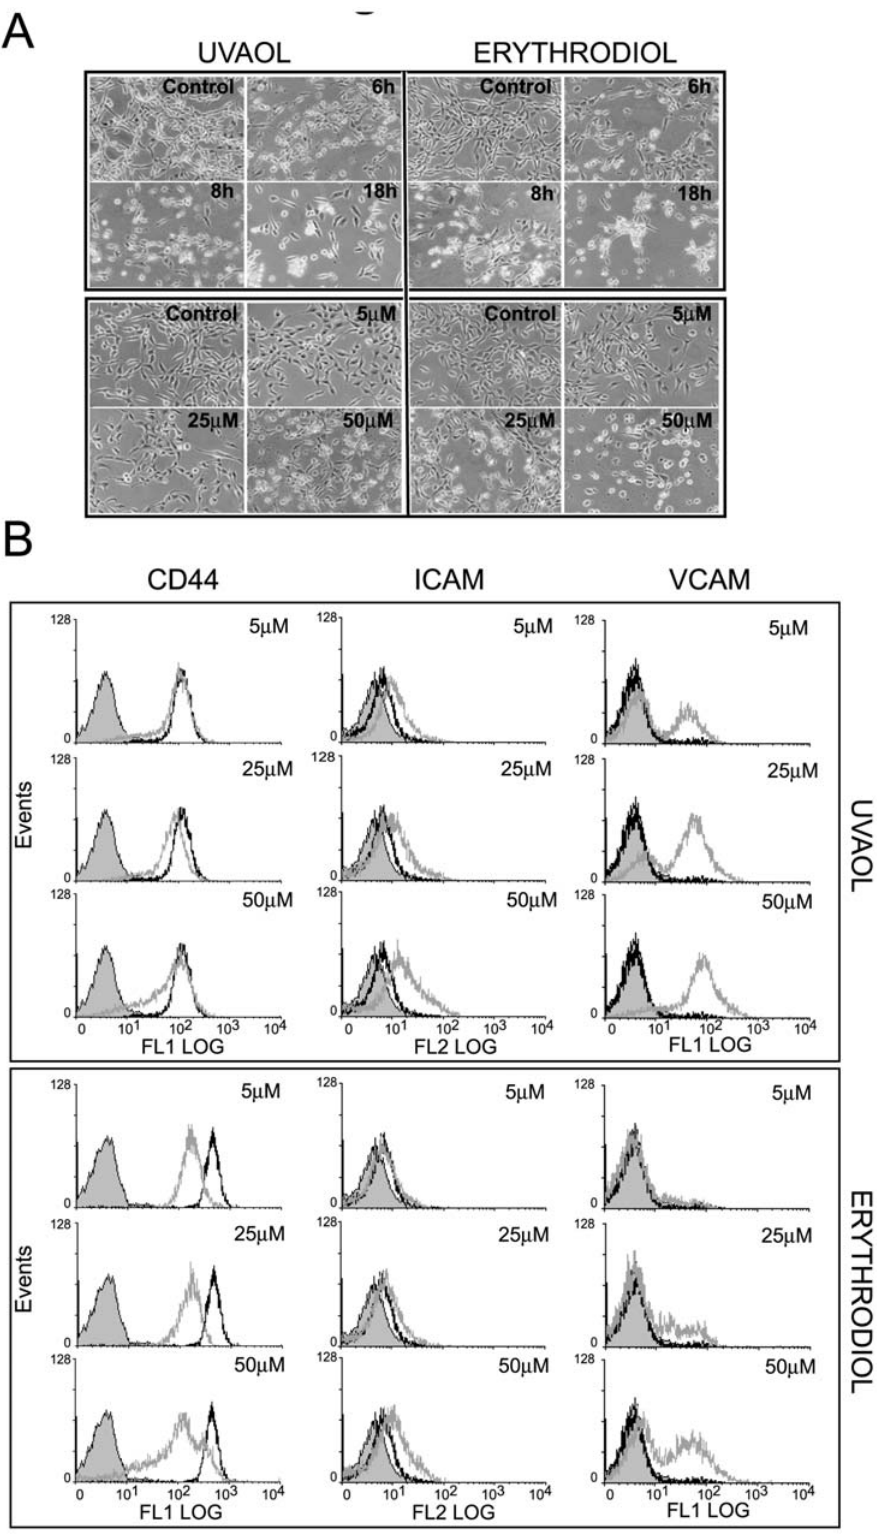
Figure 2. Erythrodiol and uvaol induce detachment on 1321N1 astrocytoma cells. A, Morphological appearance of the cells exposed to different doses of erythrodiol or uvaol for 6 h ( upper panels ) or to 25 m M erythrodiol or 50 m M uvaol for different times ( lower panels ). Cells were visualized under a phase contrast microscope Nikon Eclipse TS100 ( 6 20). B, Cells were treated with different doses of erythrodiol or uvaol for 18 h. The expression of CD44, ICAM and VCAM was determined by flow cytometry. Histograms represent one experiment out of three. Solid gray curves represent unspecific binding; empty black curves, cells cultured in the absence of treatment (control); and empty gray curves, triterpene-treated cells. doi:10.1371/journal.pone.0005975.g002 PLoS ONE |